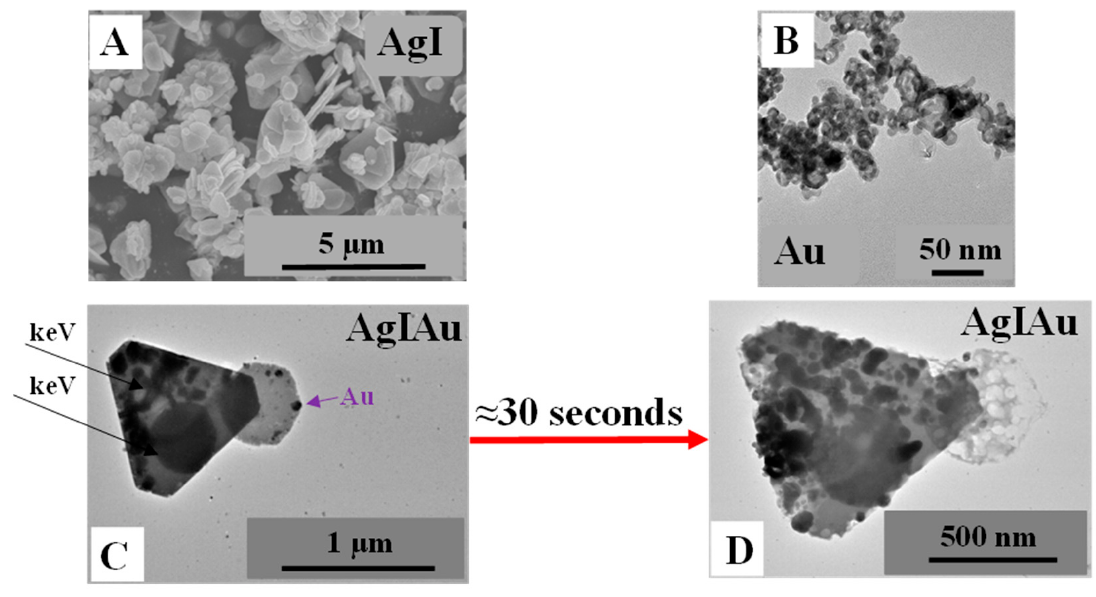
Figure 2. SEM micrograph of pyramidal structure of AgI ( a ); TEM micrographs of Au nanocages ( b ); and AgIAu composites before ( c ) and after electron beam irradiation ( d ) .